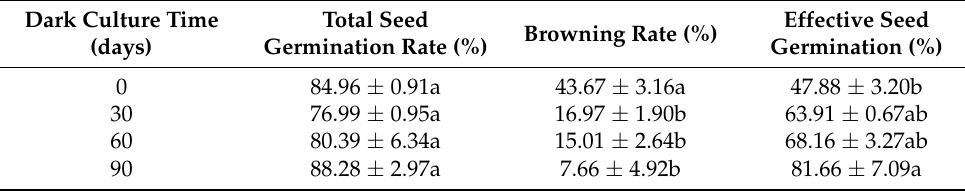
Table 3. Effect of dark culture on seed germination of Paphiopedilum tigrinum . Dark Culture Time (days)